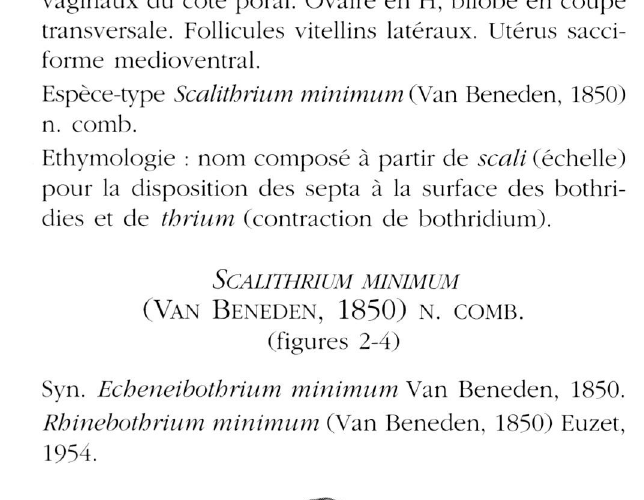
Figs 3-4. - Scalithrium minimum (Van Beneden, 1850) n.